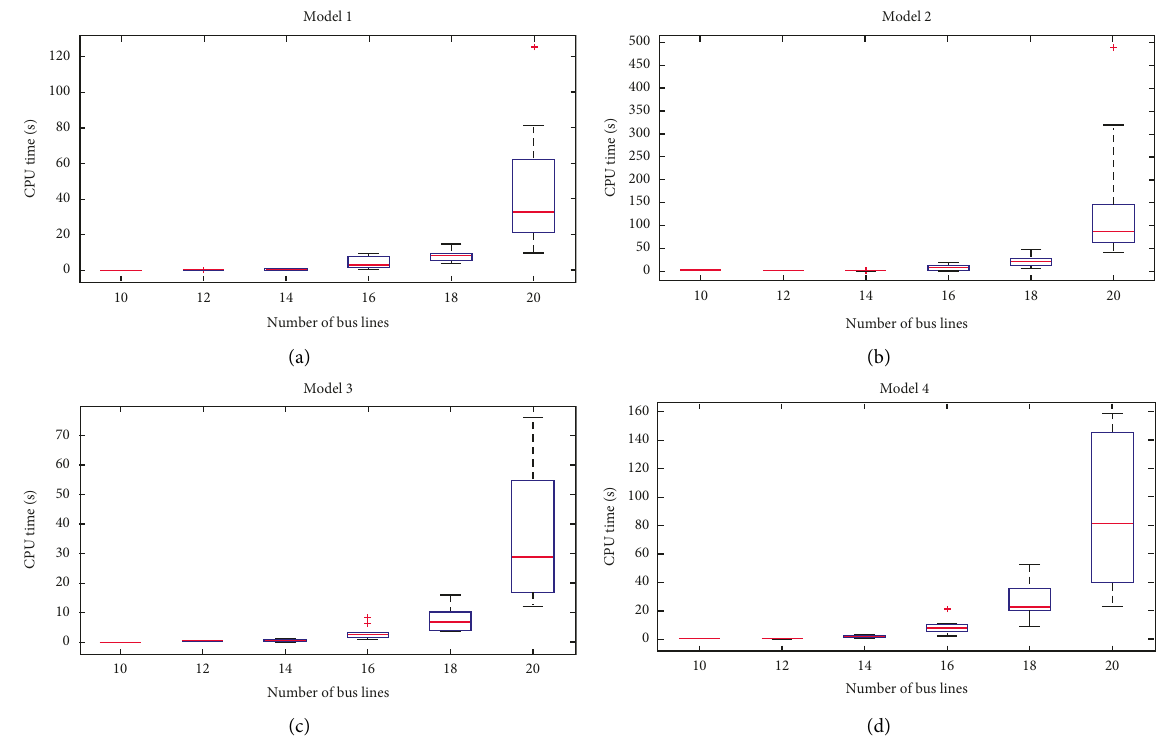
Figure 5: CPU time from the four proposed models with varying bus routes. (a) Model 1’s CPU time. (b) Model 2’s CPU time. (c) Model 3’s CPU time. (d) Model 4’s CPU time.